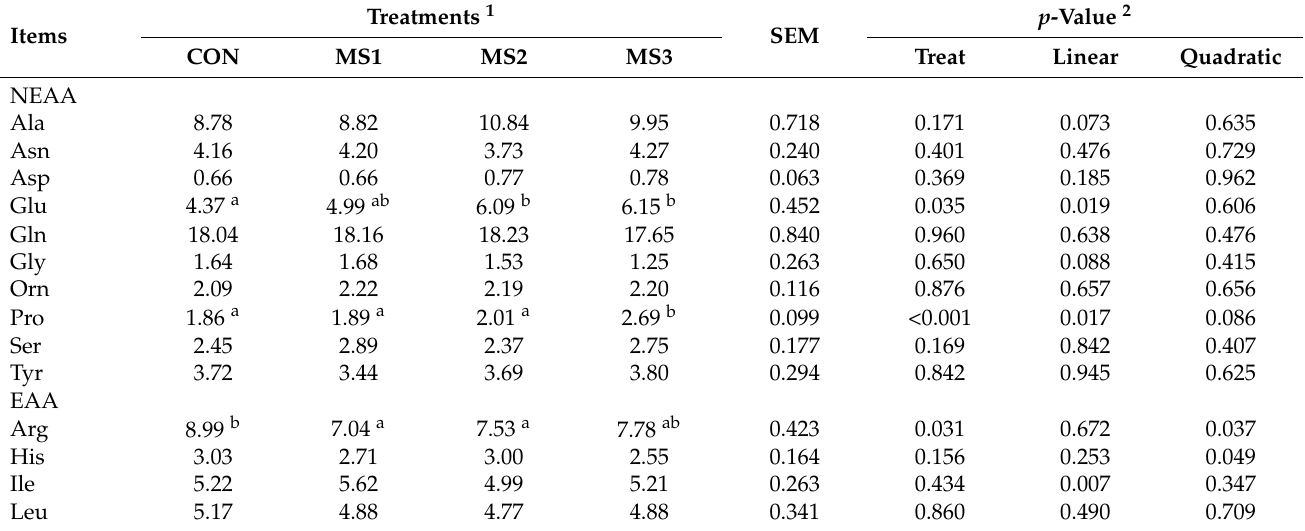
Table 6. Effect of MetaSmart supplementation in diets on serum free amino acids of yaks